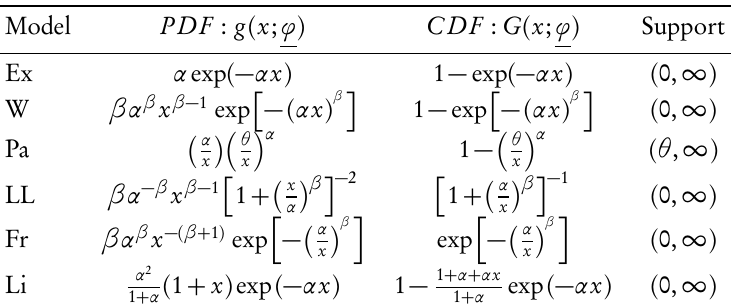
The PDF and CDF of base models of McGP